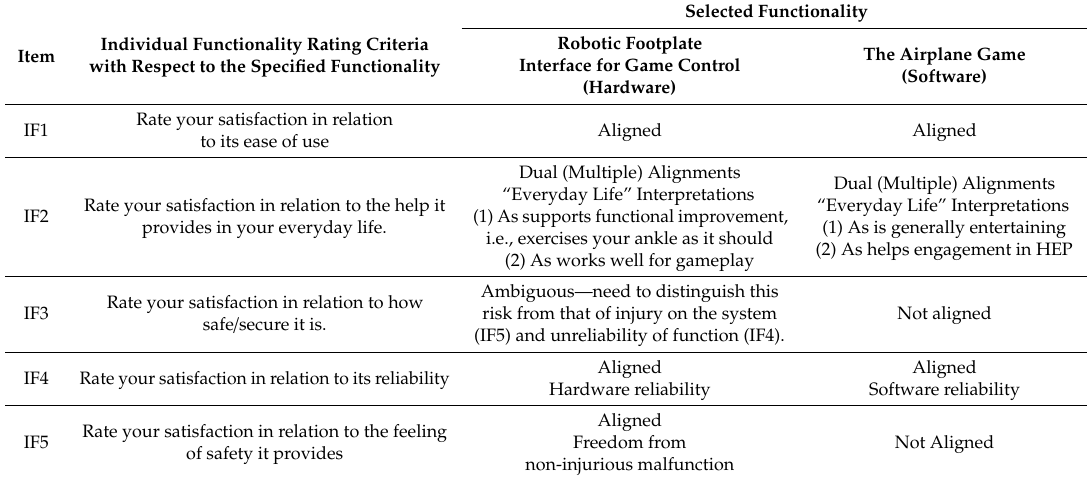
Table 6. PYTHEIA [31] scale individual functionality items applied to controller and airplane game in